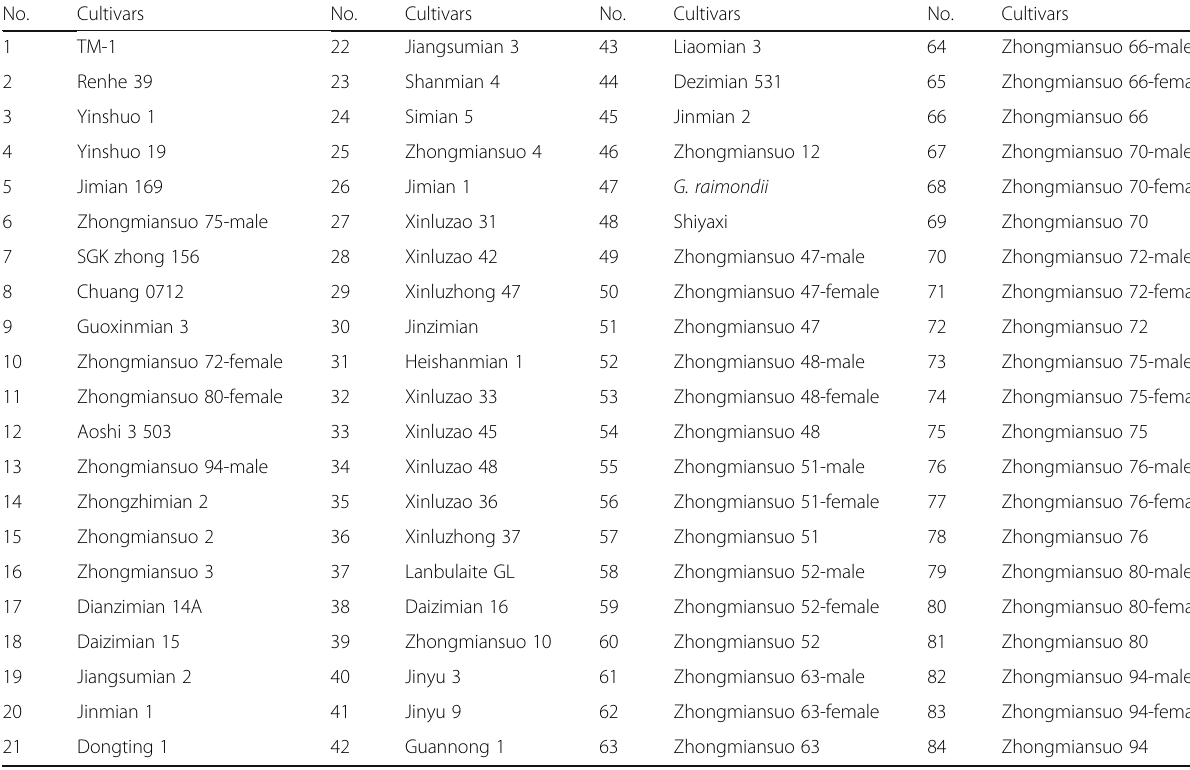
Table 1 Information on 48 base materials and 12 triplet materials